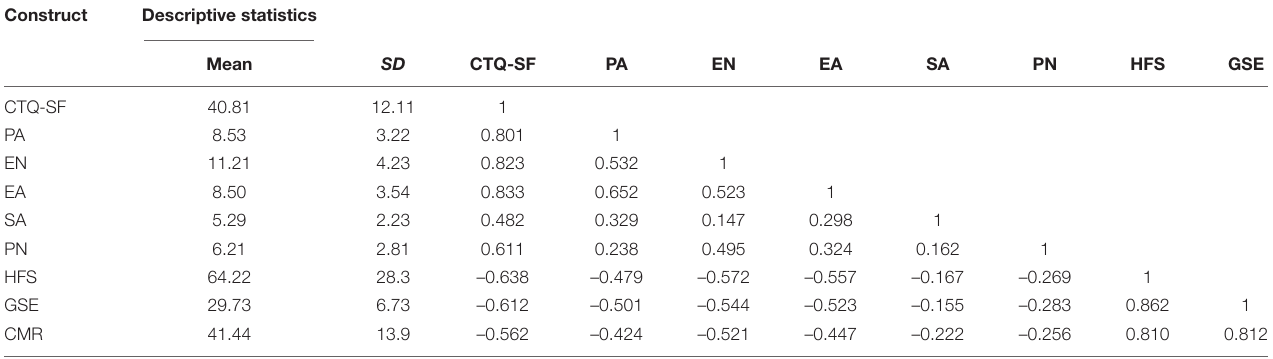
TABLE 2 | Descriptive statistics and correlation results of